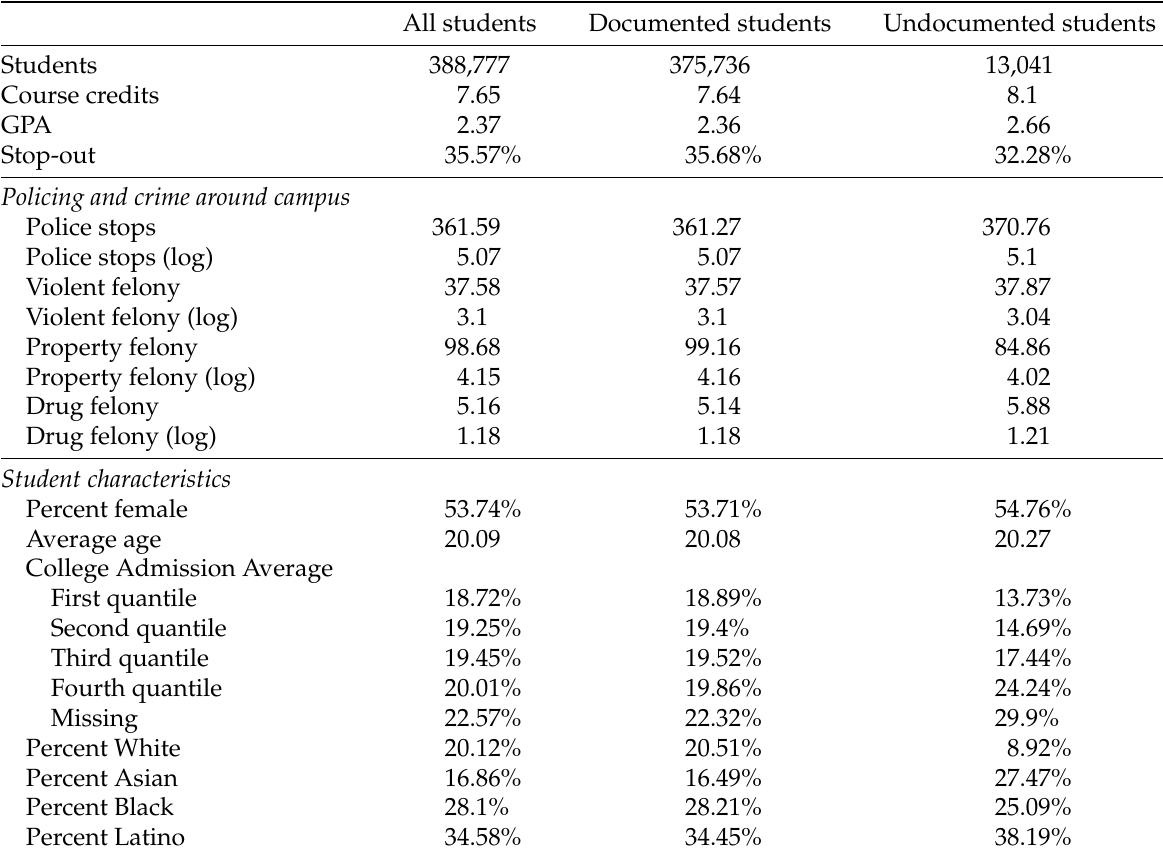
Table 1: Descriptive summary statistics for key